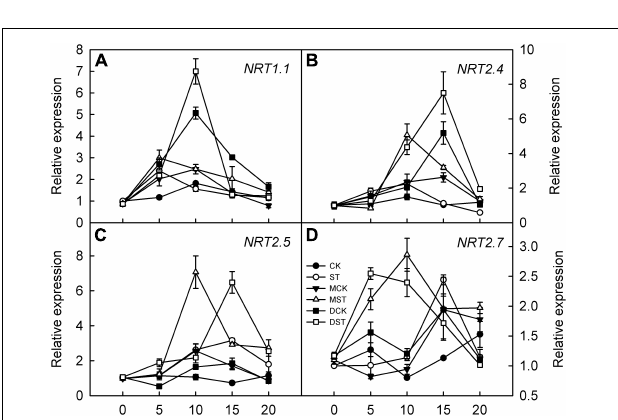
FIGURE 7 | Effects of melatonin and dopamine on expression of key genes involved in N-assimilation in roots under different treatment conditions. (A) NR. (B) NiR. (C) GS. (D) NADH-GOGAT. (E) Fd-GOGAT. Total RNA was isolated from samples at specified time points (0–20 d), converted to cDNA, and subjected to qRT-PCR. Data are means ± SD ( n = 3). CK, 2 mM K 15 NO 3 solution; ST, 0.1 mM K 15 NO 3 solution; MCK, 2 mM K 15 NO 3 solution with 0.1 µ mol/L melatonin; MST, 0.1 mM K 15 NO 3 solution with 0.1 µ mol/L melatonin; DCK, 2 mM K 15 NO 3 solution with 100 µ mol/L dopamine; DST, 0.1 mM K 15 NO 3 solution with 100 µ mol/L dopamine.